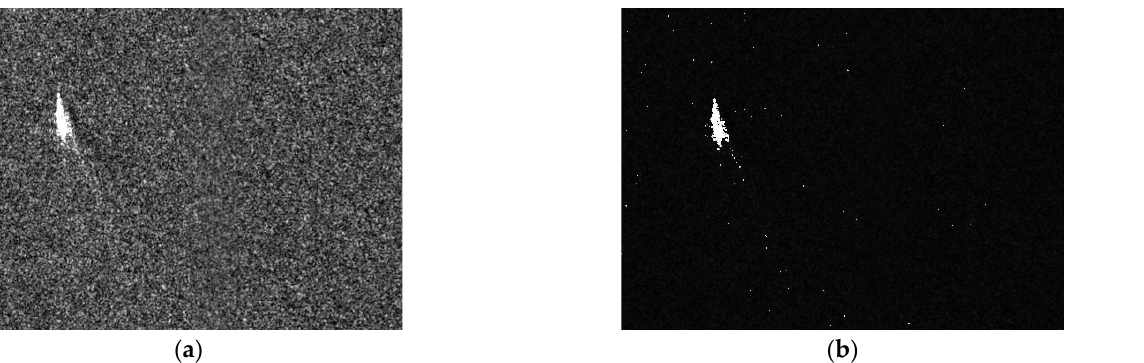
18 of 22 Figure 15. Four class samples: ( a ) original image; ( b ) the fusion ratio is 1:10; ( c ) target enhancement; ( d ) target reduction; ( e ) target segmentation; ( f ) target shadow region location.